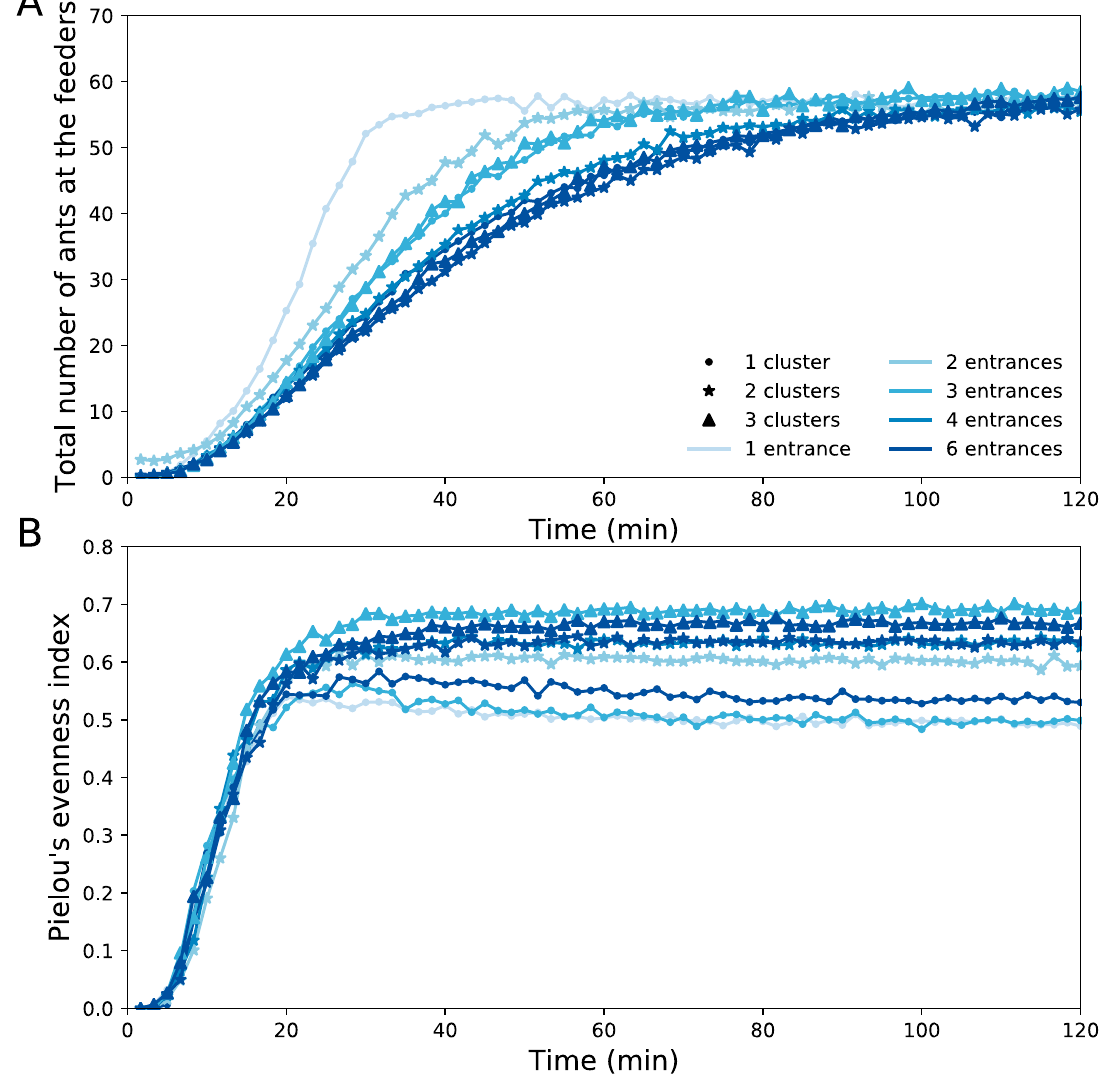
Figure 4. Theoretical dynamics of the exploitation of eight food sources . ( A ) Total number of ants present on the food sources as a function of time. ( B ) Pielou’s evenness indices accounting for the distribution of ants among the feeders as a function of time. Symbols represent the total number of clusters (dot = 1, star = 2, triangle = 3) and the gradation of colours represents the total number of entrances (one, two, three, four, or six).